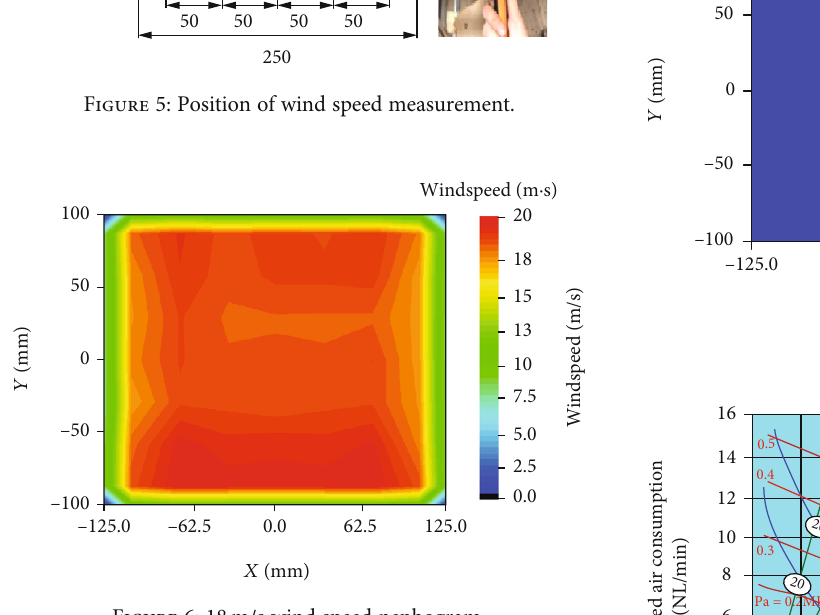
Figure 6: 18 m/s wind speed nephogram.